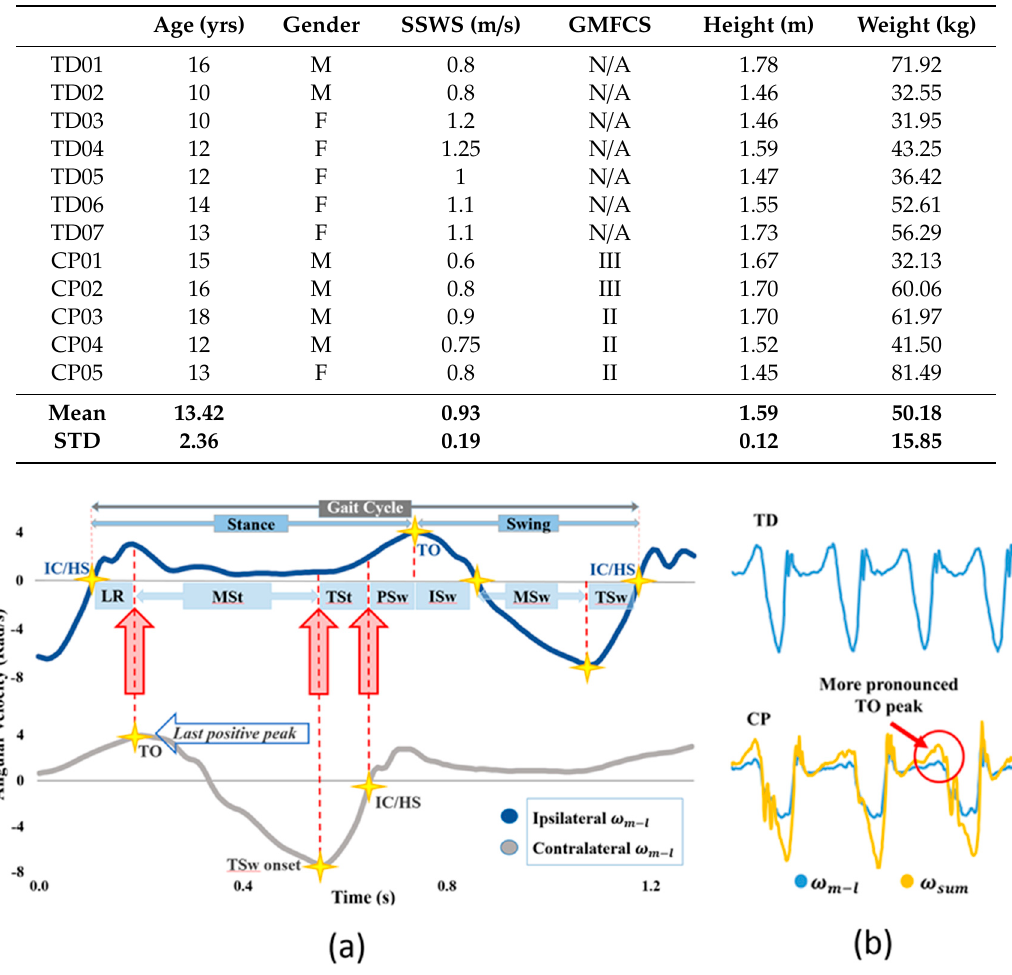
Figure 2. ( a ) Shank angular velocity about the medio-lateral axis ( ω ml ) for typically developing children and healthy adults during treadmill walking. Gait phase onset is based on the indicated peaks and zero-crossings. Four gait phase events are detected using ipsilateral shank angular velocity (loading response (LR), initial swing (ISw), mid-swing (MSw) and terminal swing (TSw). The three remaining gait phase events are detected using contralateral shank angular velocity (mid-stance (MSt), terminal stance (TSt) and pre-swing (PSw)). The onset of LR corresponds to initial contact (IC) / heel strike (HS) and the onset of ISw corresponds to toe-o ff/ end-contact (TO / EC); ( b ) Representative shank angular velocity about the medio-lateral axis for a typically developing child (top) and a child with cerebral palsy (CP) (bottom). A distinct peak is visible at the onset of ISw (TO / EC) in TD while the peak is less distinct in CP. The sum of all three components of shank angular velocity ( ω sum ) shows a more distinct peak at ISw onset, and was initially used for ISw detection in children with CP (bottom).